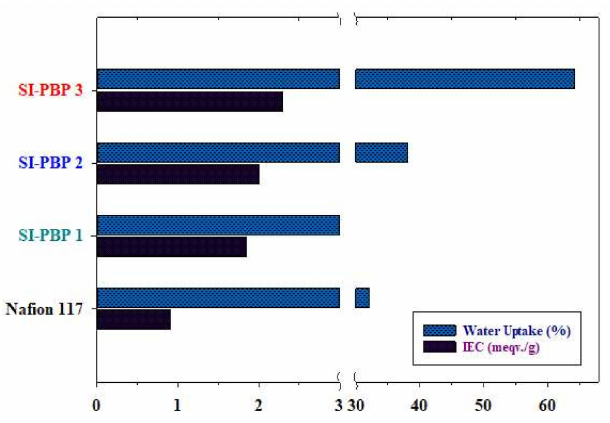
Figure 3. Ion exchange capacity (IEC) and Water uptake (WU) for the SI-PBP polymers membranes. The SI-PBP membranes show comparably lower-dimensional changes ( ∆ t and ∆ l) than Nafion 211 ® . The SI-PBP membranes exhibited higher ∆ t (7.5%, 12.5%, and 34.0%) and ∆ l (4.81%, 8.0%, and 16.17%) values whereas Nafion 211 ® showed ( ∆ t = 31.98 and ∆ l = 14.2%) (Table 1). Noticeably, ∆ l values of SI-PBP membranes were significantly lower than the ∆ t values due to the C-C bonded aromatic rigid polymer